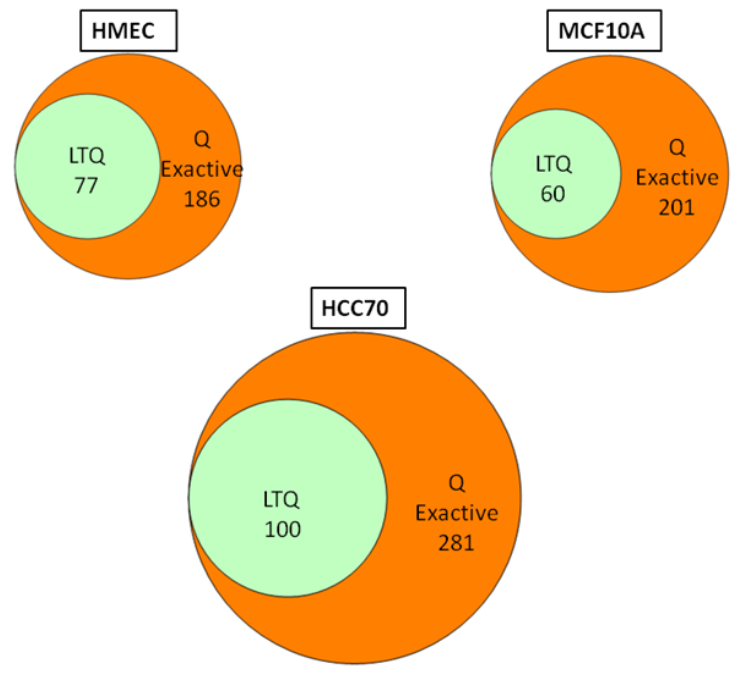
Figure 2. Venn diagrams of the glycoproteins identified by the Q Exactive MS and the linear ion trap-instrument (LTQ) MS from three breast cell lines. All glycoproteins found in LTQ MS analyses were also found in Q Exactive MS